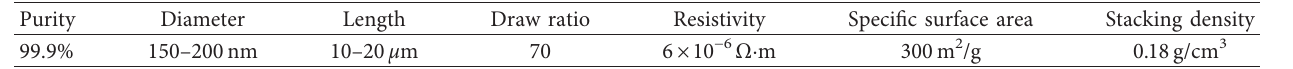
Table 8: Physical parameters of carbon nanofibers.